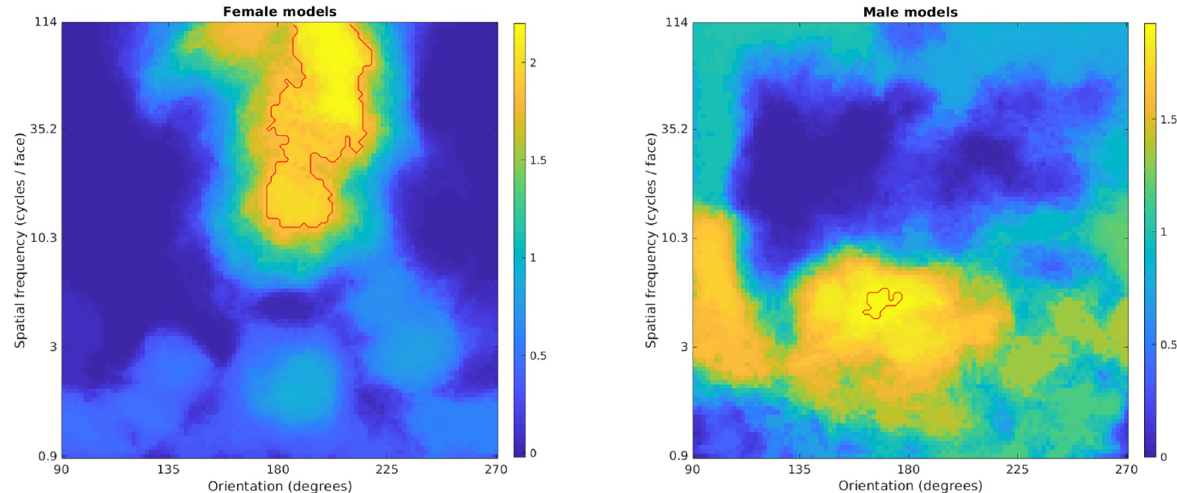
Fig 10. TFCE-values for correlations between the normative attractiveness ratings and frequency spectra. Statistically significant clusters are outlined in red. The 90/270 degrees represent horizontal frequencies and 180 degrees the vertical frequencies. There were significant correlations between attractiveness and amplitude for both female faces (at high vertical frequencies) and male faces (at low vertical frequencies).